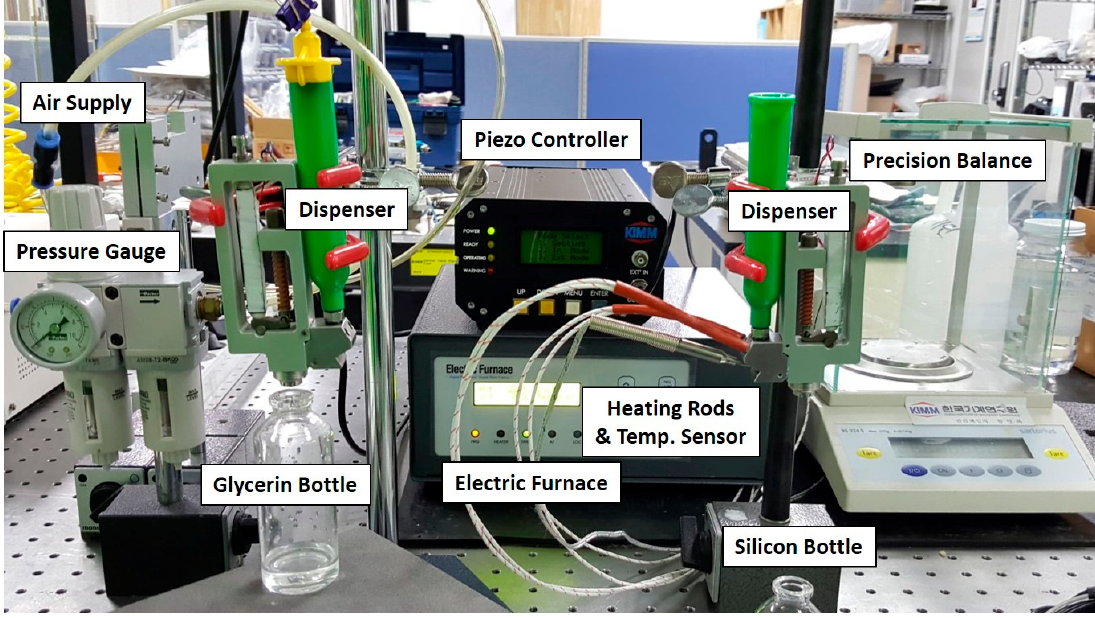
Figure 9. Jetting experiment assembly and test system for hinge-lever type piezo-driven dispenser.